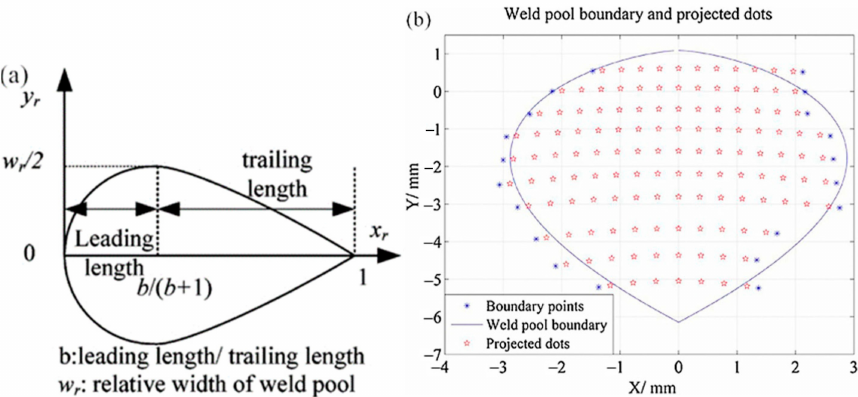
Figure 5. The analytic model for fitting the interpolated weld pool. ( a ) Boundary model of the weld pool; ( b ) boundary fitting of the weld